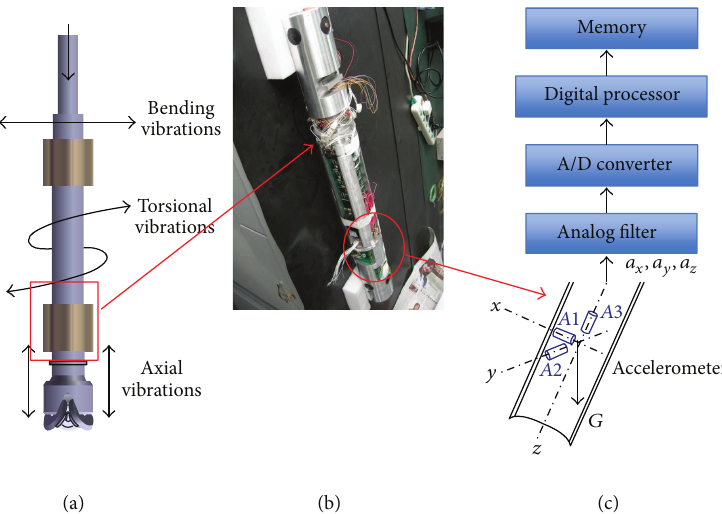
Figure 1: Measurement system. (Part (a) is the schematic diagram of drill string mechanism. Part (b) is the structure chart of mearsurement system, installed inside the central axis of the drill collar shown in red block. Part (c) indicates the install configuration of triaxial accelerometers; the signals will be stored in the memory chip; G is the acceleration of